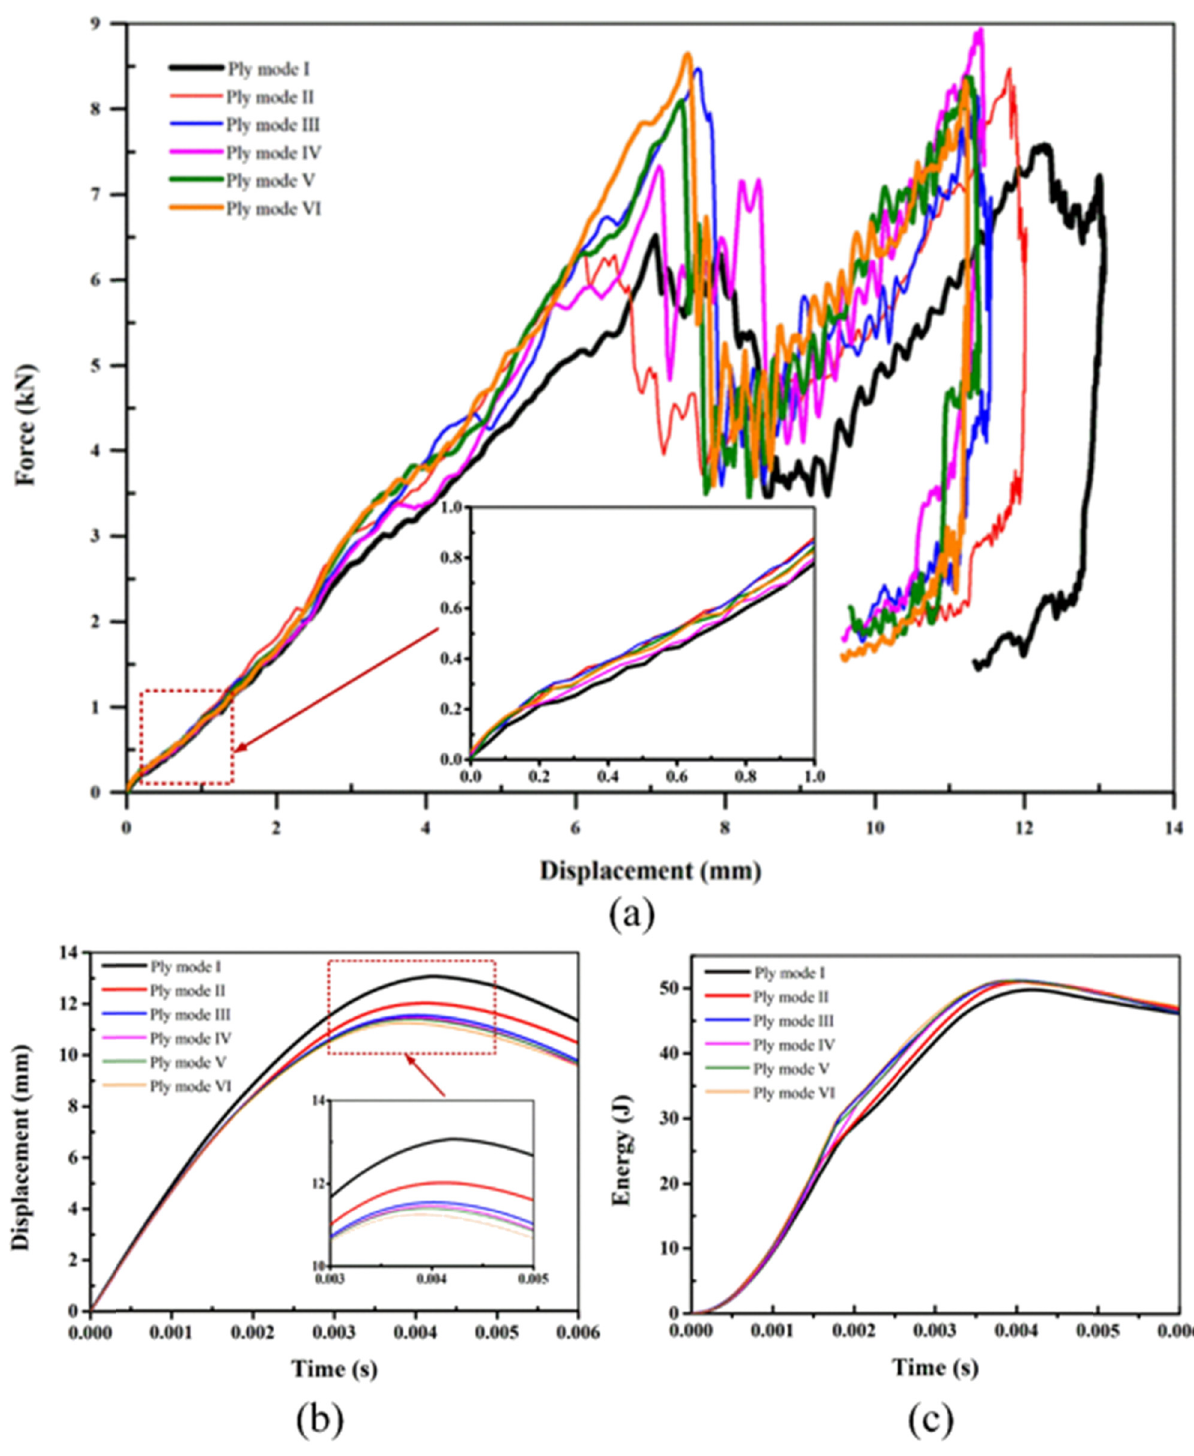
Figure 8: Typical force - displacement ( a ) displacement - time ( b ) and energy - time ( c )